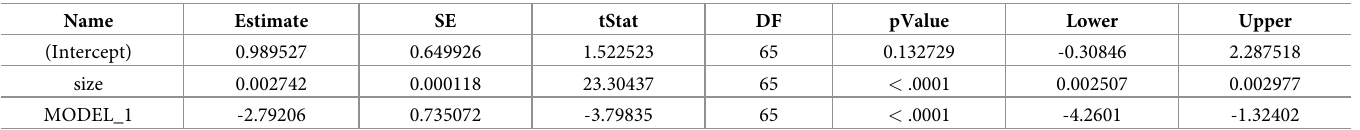
Table 5. Fixed effects coefficients of the model explaining the testing time in terms of the HPN/GPN and the problem